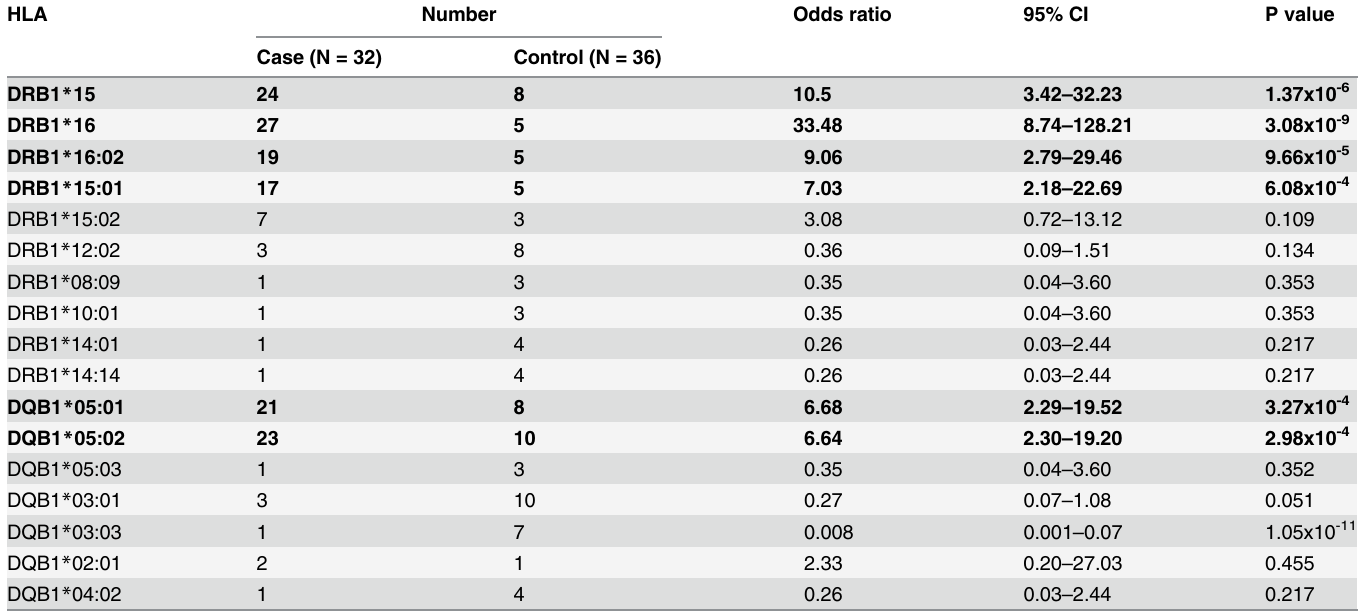
Table 3. HLA class II genotypes of healthy volunteers (No. 1 – 30) and pulmonary tuberculosis (No. 31 – 36) without anti- IFN- γ autoantibody (control group). HLA-DRB1 and DQB1 also demonstrated similarly significant association with the disease (Table 5). There was no significant change in the results when the pulmonary tuberculosis group was excluded from analysis. The HLA allele frequencies of control group (S1 – S4 Tables) were comparable to other Thai cohorts [12, 13].